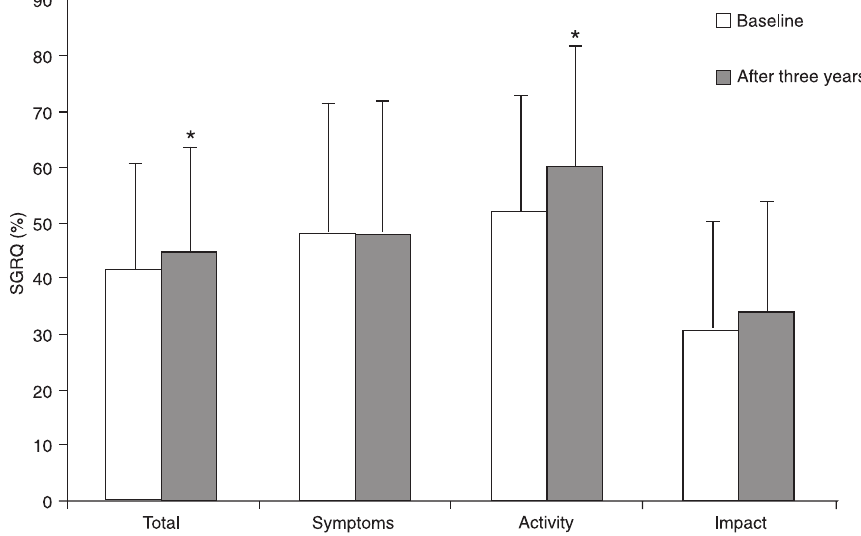
Figure 1. Mean SGRQ (Saint George’s Respiratory Questionnaire) domains at baseline and after 3 years. *P < 0.05, baseline values compared to values observed after 3 years (paired t -test or Wilcoxon test).